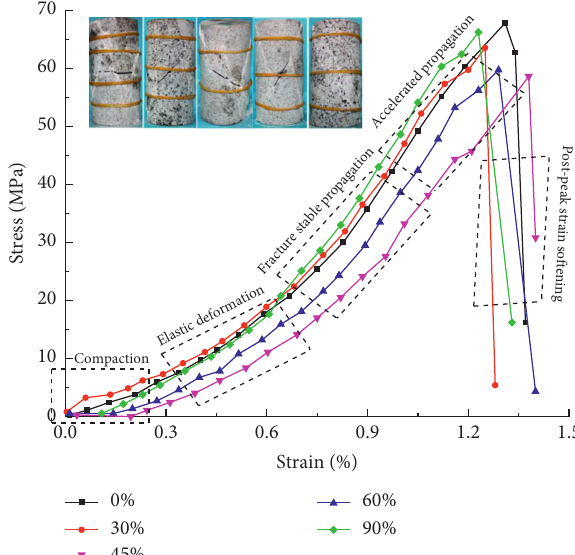
Figure 1: Failure characteristics and stress-strain curve.